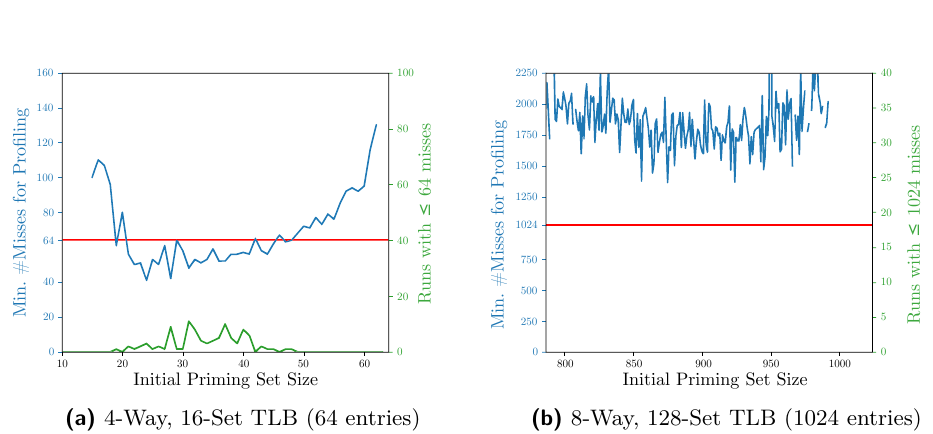
Figure 7: The blue line depicts the minimum experienced misses to obtain a functional probabilistic eviction set during profiling of Prime+Prune+Probe over 100 , 000 trials for each initial priming set size. Assuming a re-randomization threshold of N (the number of entries available), the green line depicts the total number of successful runs out of the 100 , 000